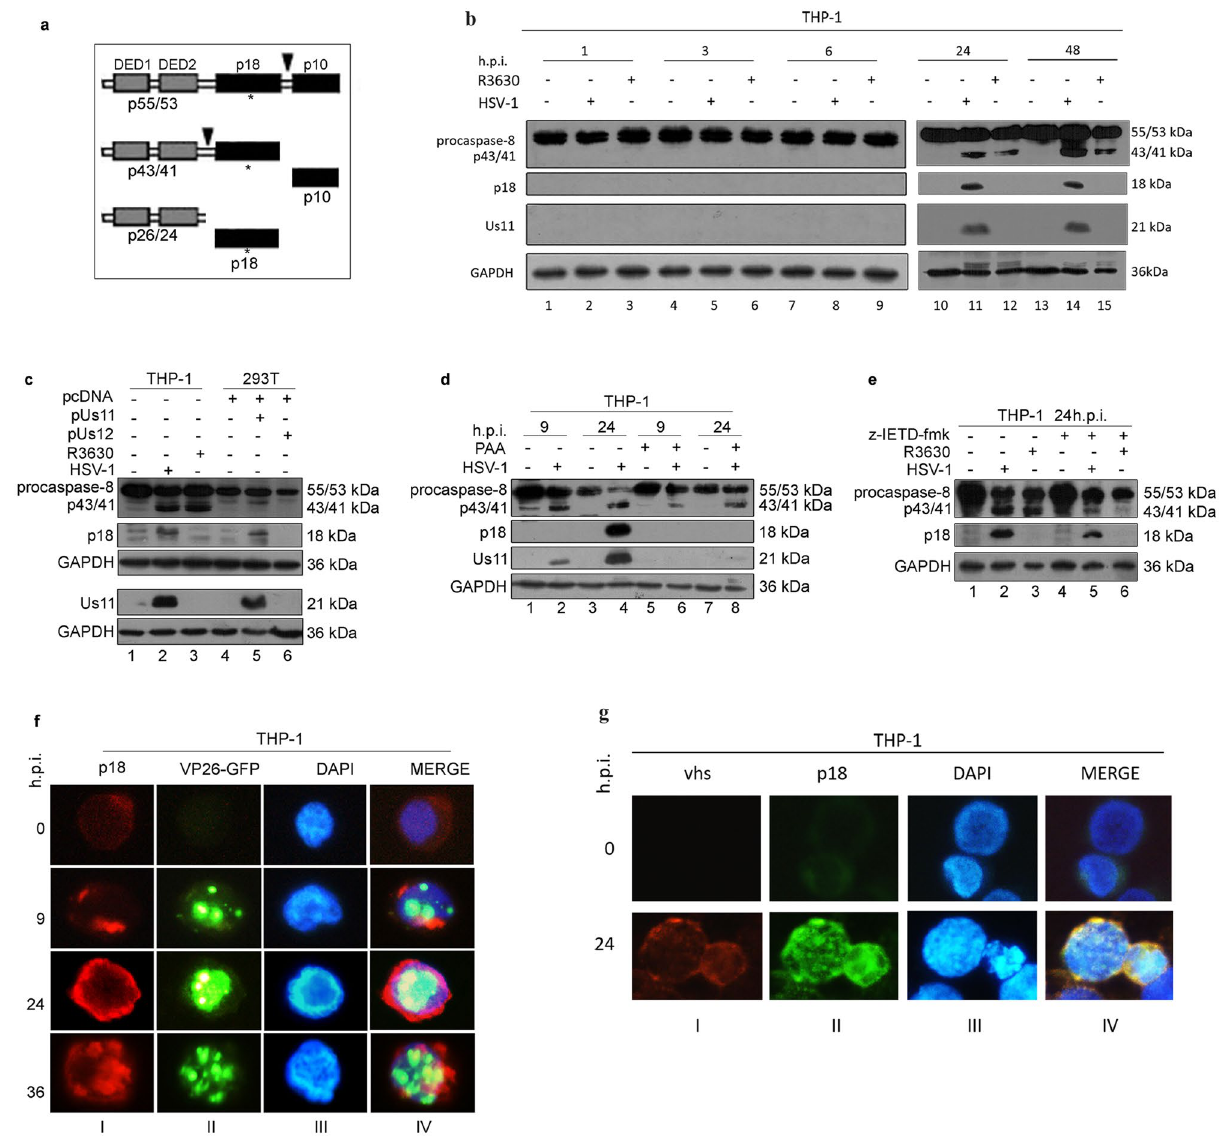
Figure 1. Cleavage and activation of caspase-8 during HSV-1 replication in THP-1 and effect of Us11 deletion. ( a ) Schematic representation of the “two-step” model proposed for cleavage and activation of caspase-8; ( b ) time- course analysis of caspase-8 in THP-1 cells infected or not with HSV-1 and R3630 (ΔUs11/Us12) viruses; ( c ) analysis of caspase-8 cleavages in THP-1 cells infected or not with HSV-1 or R3630 (ΔUs11/Us12) for 24 h and 293 T cells transfected with pUs11 and pUs12 plasmids and collected at 72 h post-transfection; ( d ) analyses of caspase-8 cleavage in THP-1 cells infected with HSV-1 and treated or not with PAA (300 µg/ml); ( e ) analysis of caspase-8 cleavage in THP-1 cells infected with HSV-1 or R3630 (ΔUs11/Us12) and treated or not with the caspase-8 inhibitor z-IETD-fmk (100 µM); The full-length (p55/53) and cleaved form (p43/41 and p18) of caspase-8 was detected by using a specific antibody directed to the p18 subunit (ALX-804–242-12F5). GAPDH was used as loading control; ( f ) fluorescence microscope analysis of p18-fragment in THP-1 infected with HSV- 1-VP26GFP. The cells were infected or not with HSV-1-VP26GFP and stained with anti-p18 antibody in red (I). The green dots are representative of autofluorescent VP26GFP protein (II). Hoechst was used to stain the nuclei (III); the IV column represents the merged images; ( g ) co-localization of p18 with the late gene product VHS. THP-1 cells were infected or not with HSV-1 and stained with both anti-p18 (II) and anti-VHS antibodies (I). Hoechst was used to stain the nuclei (III); the IV column represent the merged images. Magnification of images × 63. The b and c were cropped from different expositions of the same gel to improve the clarity and conciseness of the presentation. Original Western blot and corresponding images of the fluorescence microscope analysis showed in f and g are presented in the Supplementary file (Fig.